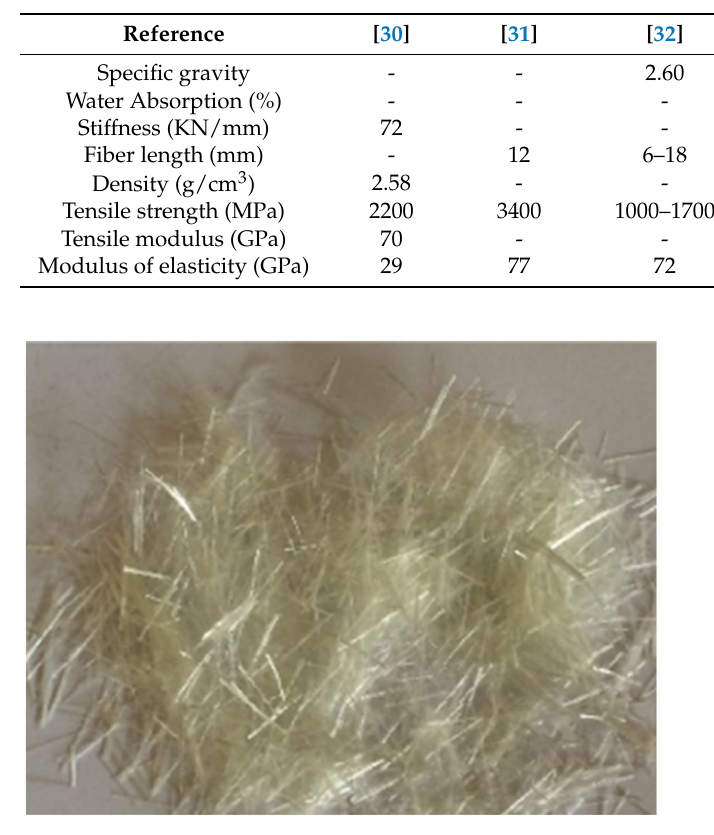
Figure 1. Glass fiber: used with permission from Elsevier